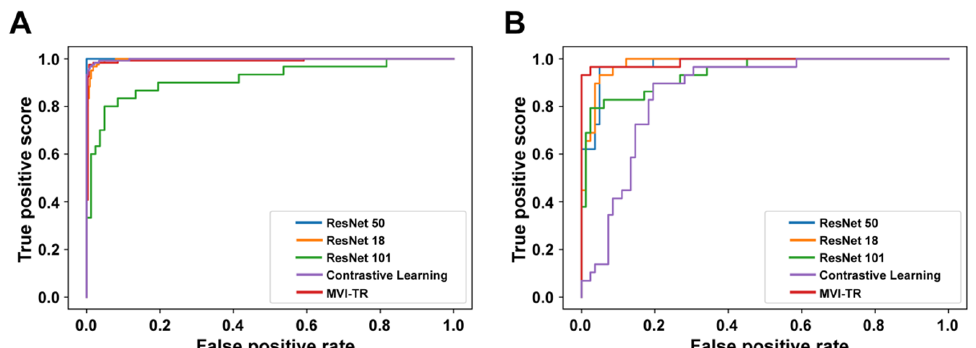
Figure 4. The receiver operating characteristic (ROC) curves of 5 different models. Receiver operating characteristic (ROC) curves of the contrastive learning model, MVI-TR, and baseline ResNet-like models. ( A ) ROC curves on the training cohort. ( B ) ROC curves on the validation cohort.